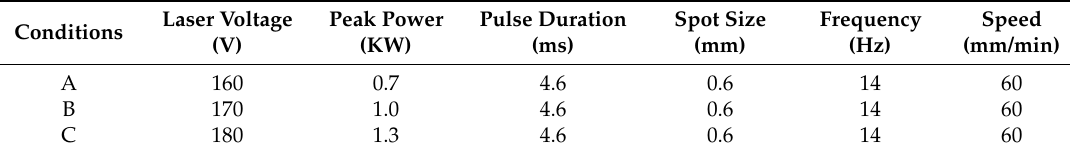
Table 2. Repair welding parameters adopted in this experiment.